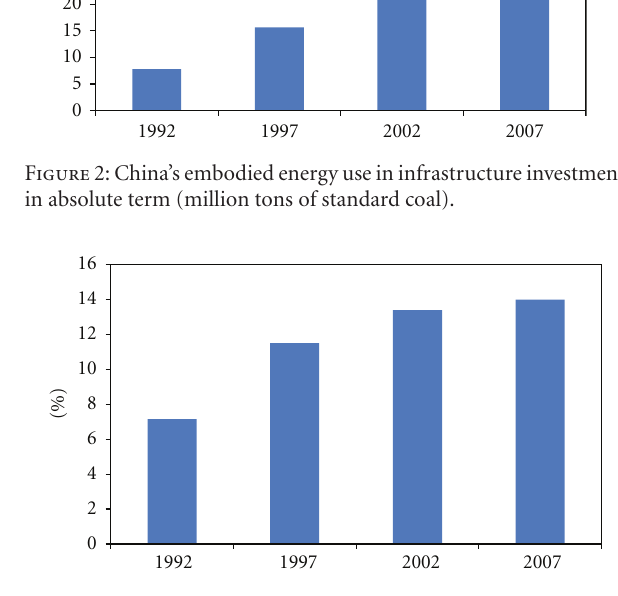
Figure 3: China’s embodied energy use in infrastructure investment in percentage of its total energy